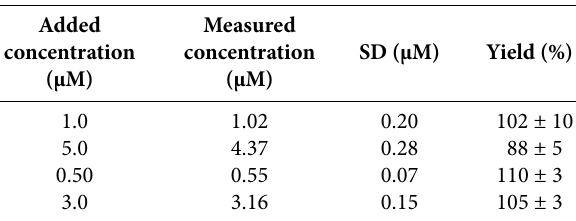
Table 1. The analytical yield of the FIA-TLS method for determina- tion of total iron added as Fe(III) Added